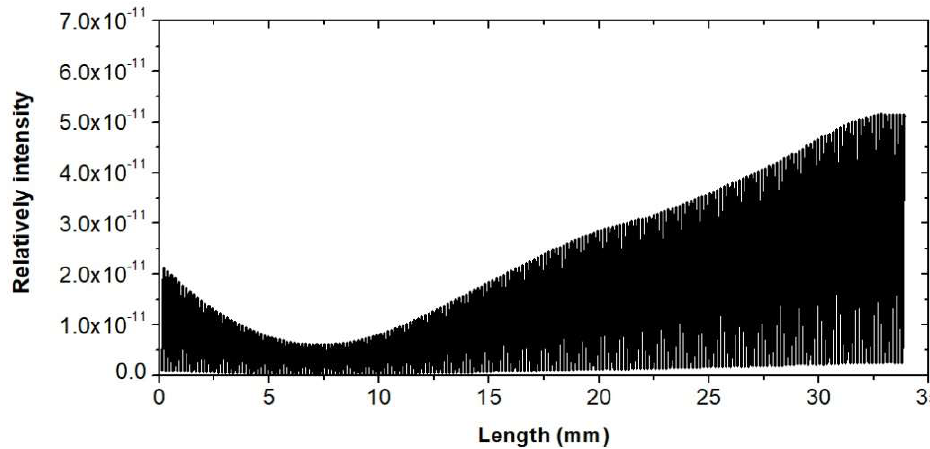
Figure 13. Power curve of the amplification section. Table 3. Parameters of the CE-HHTWT.